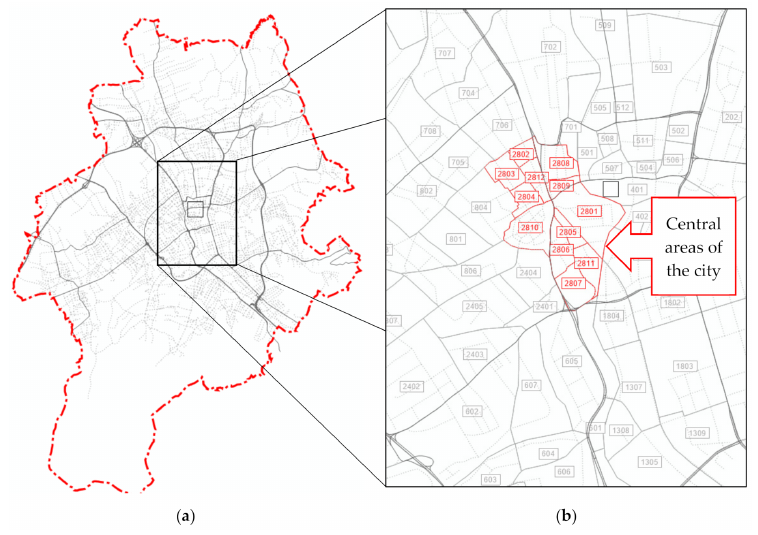
Figure 3. Road and street network of Bielsko-Biała city and of the central areas of the city: ( a ) road network allowed for through traffic; ( b ) central areas of the city (in scenarios W1 and W3 without through